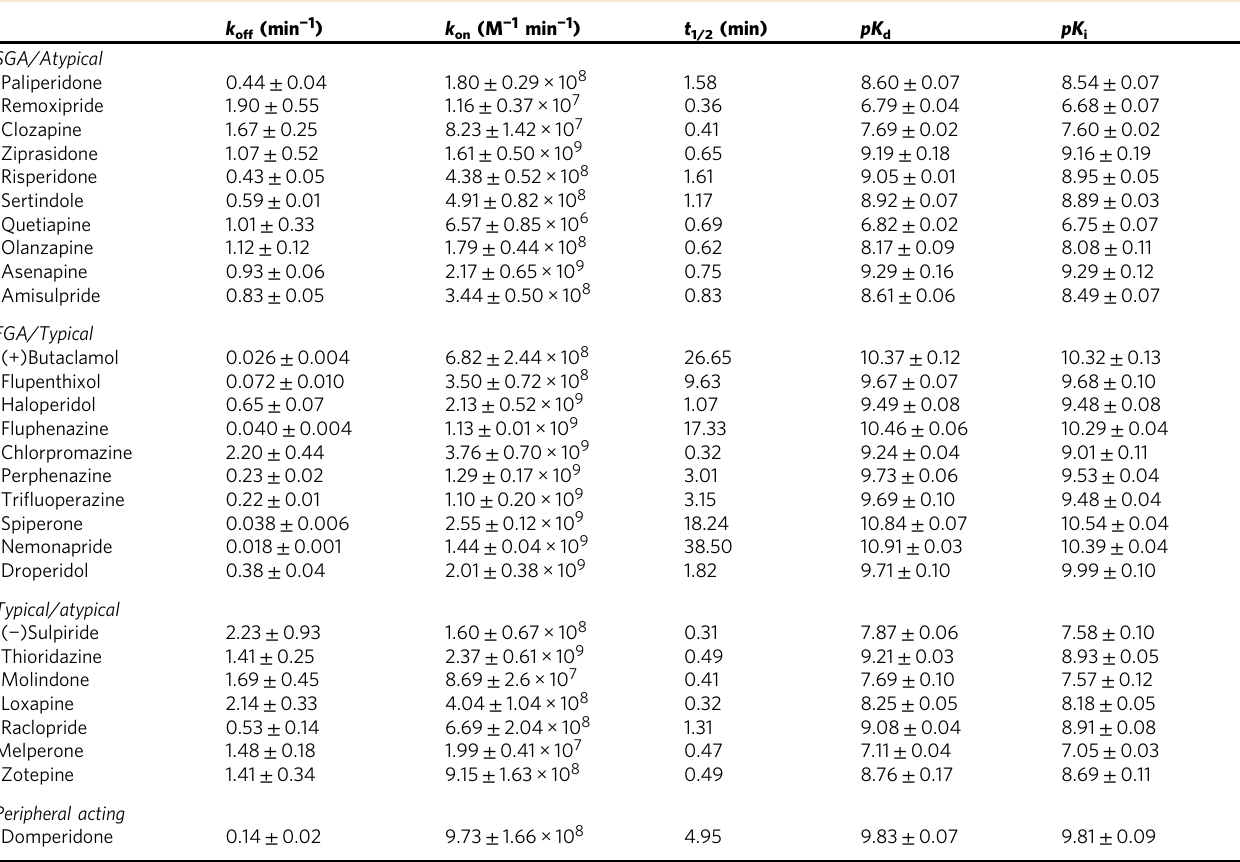
Data are mean ± s.e.m. from four experiments performed in singlet. FGA/typical and SGA/atypical classi fi cation is based on reference sources 2, 3,30 . A number of APDs have been classi fi ed as both typical and atypical APDs in separate studies. To recognize this, we have placed these drugs in a third group “ typical/atypical ” that includes sulpiride 60 – 62 , melperone 7, 62, 63 , loxapine 58, 59, 64 , molindone 65 – 67 , zotapine 7, 61 , raclopride 68, 69 , and thioridazine 62, 66, 70 . Domperidone is not an APD and is used to block D 2 receptors in the